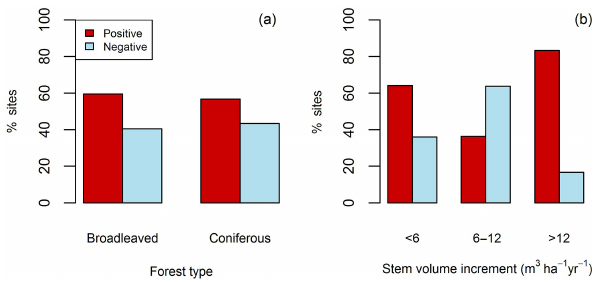
Figure 6. Percentage of occurrence of positive and negative trends of DOC concentration in soil solution separated by (a) forest type and (b) stem volume increment (m 3 ha − 1 yr − 1 ) .